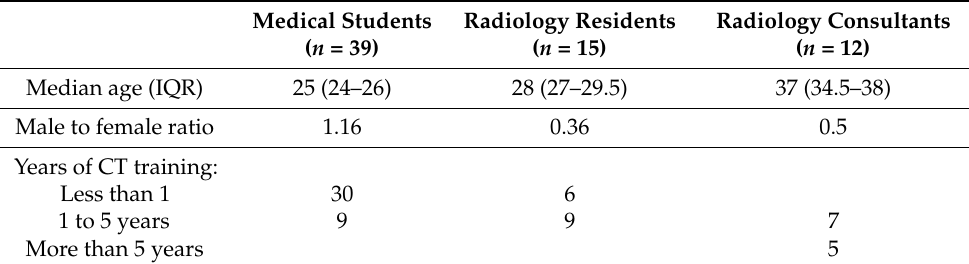
Table 1. Demographic details of respondents. IQR—Interquartile range.